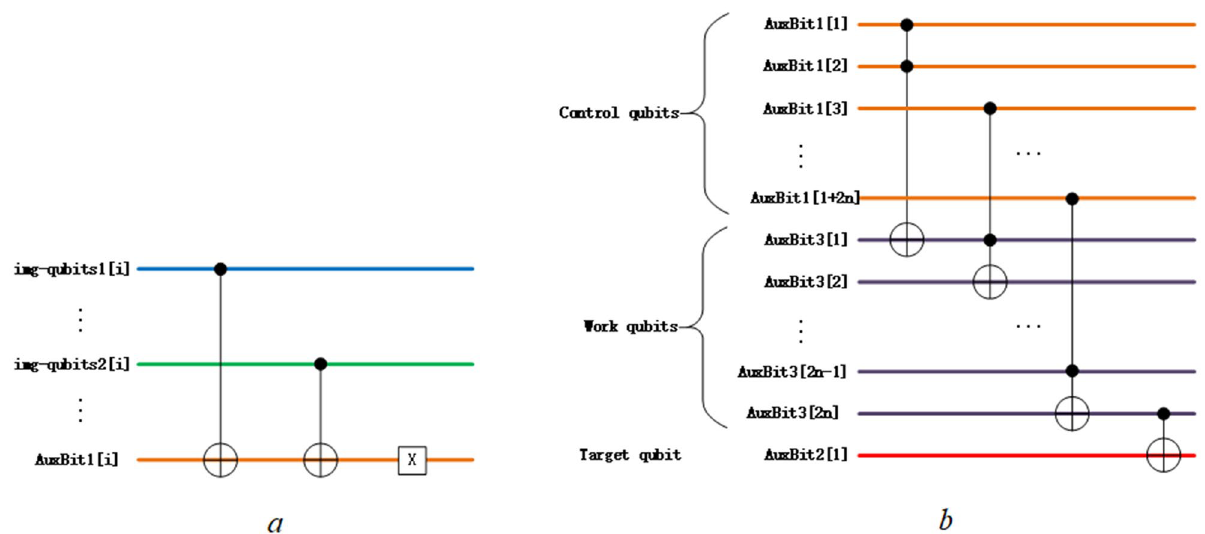
Figure 2. ( a ) The quantum circuit for comparing qubits from img-qubits1 and img-qubits2. This circuit defines the mapping between two NEQR image strings and AuxBit1. The output is XNOR of two input. ( b ) The quantum circuit that compresses |11…11 > to |1 > and the other states to |0 > . This circuit equals the Control-Not gate conditioning on the whole AuxBit1. The qubits with the same color as in Fig. 1 have the same